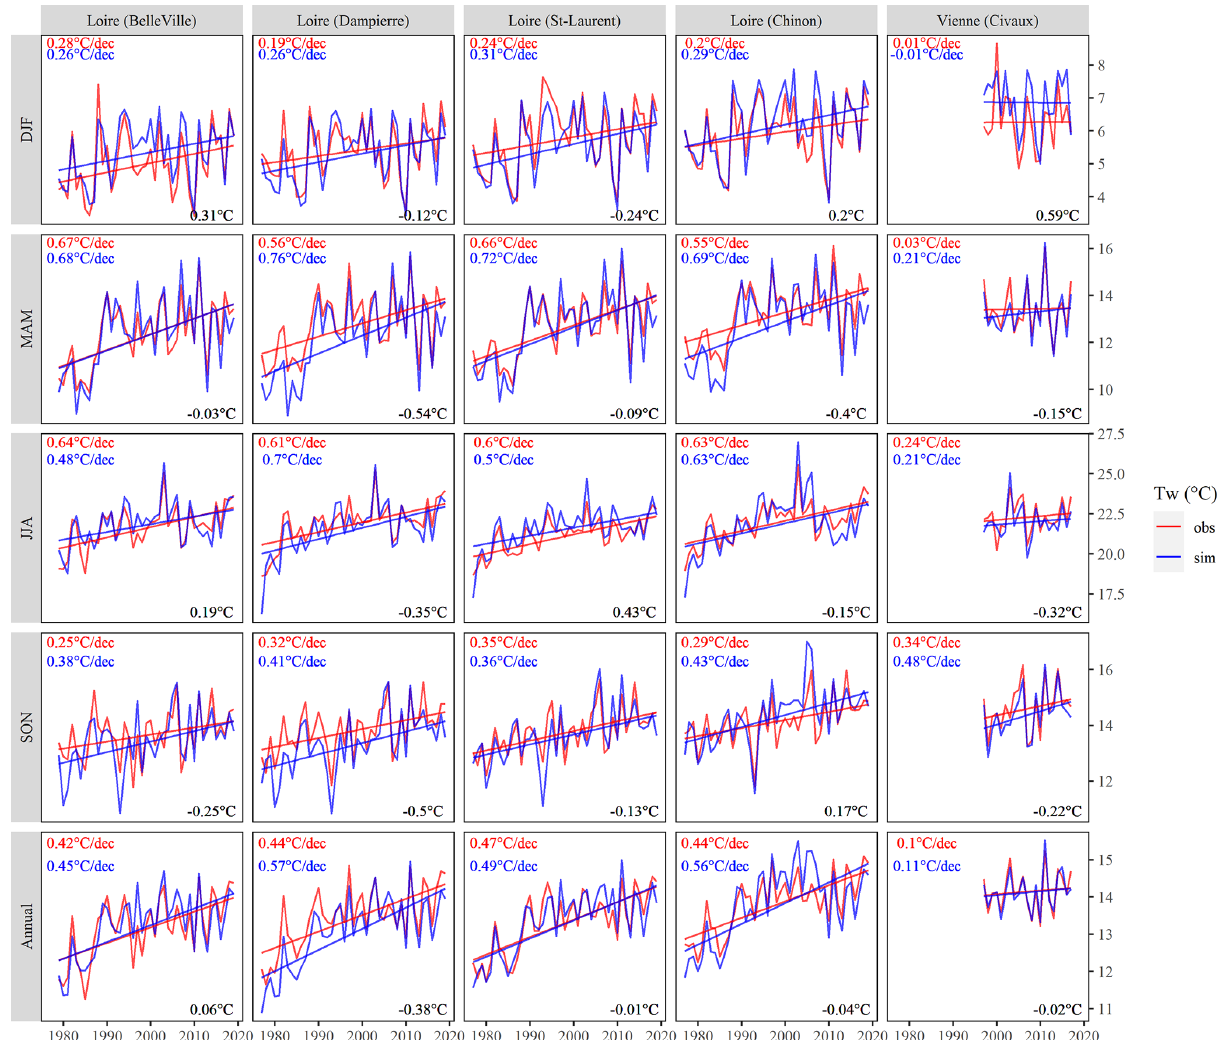
Figure 2. Seasonal and annual time series of observed and simulated T w at stations with at least 20 years of long-term continuous data between 1977 and 2019 (see Table 1 for more information). The red and blue solid lines show the trend in observed and simulated T w . Numbers in red and blue in the top left corner of each graph show trend magnitudes (Sen’s slope) in observed and simulated T w . Numbers in black in the bottom right corner of each graph show the mean bias of the reconstruction.